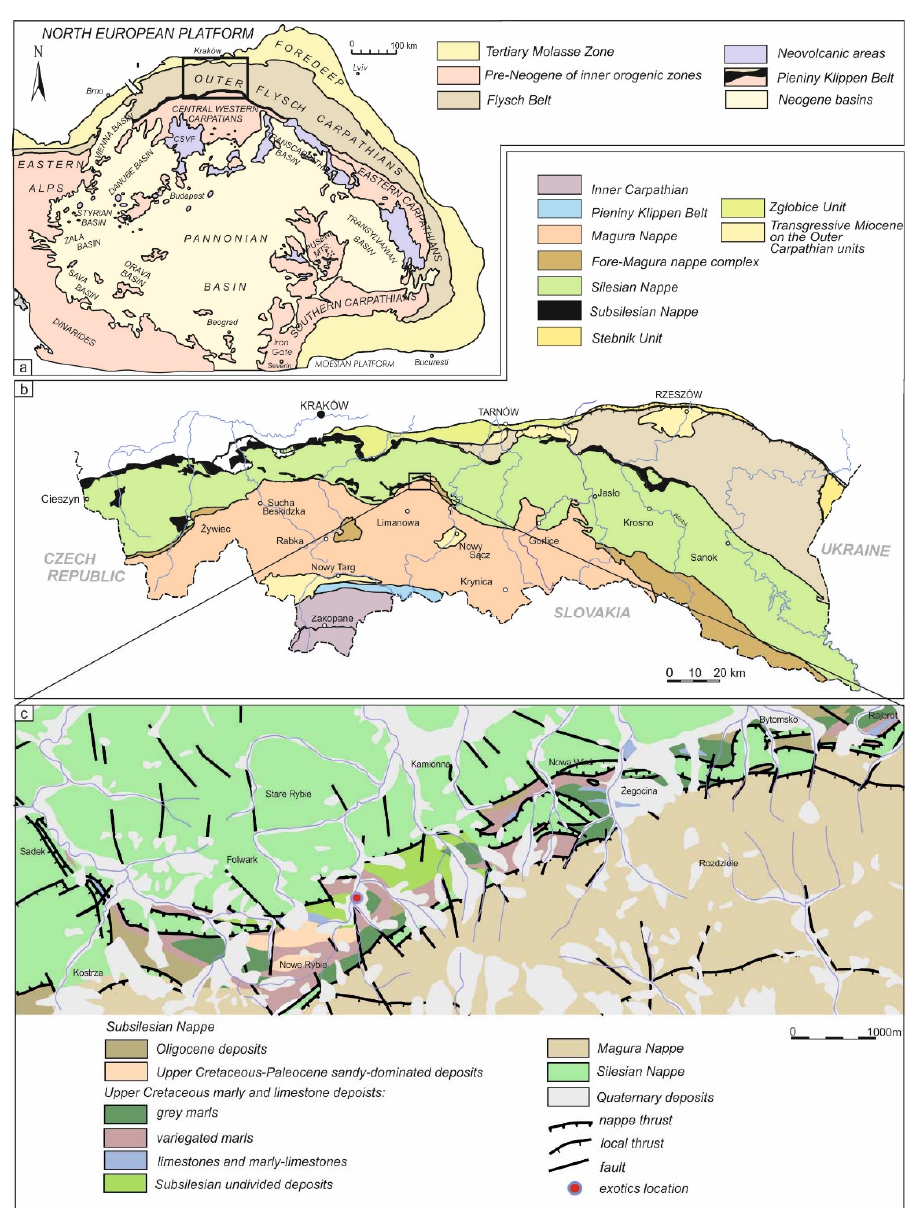
Figure 1. Location of the study area on ( a ) a simplified geological map of the Carpathian chain within Europe, ( b ) the general geological structure of Carpathians in Poland (map constructed using information included in [3–5,8] and ( c ) on a detailed geological map of the Ż egocina Zone (constructed using information included in [9]).